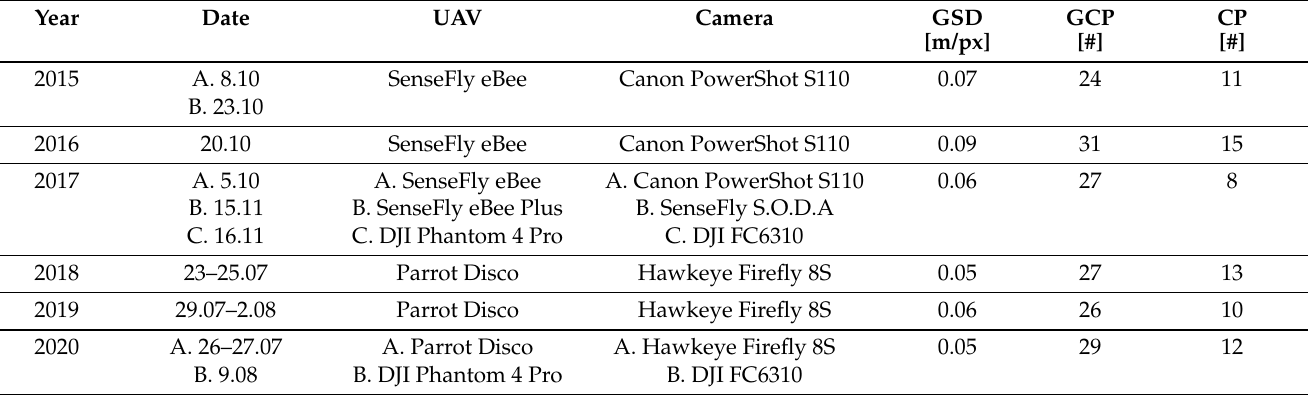
Table 1. Summary of the characteristics of the